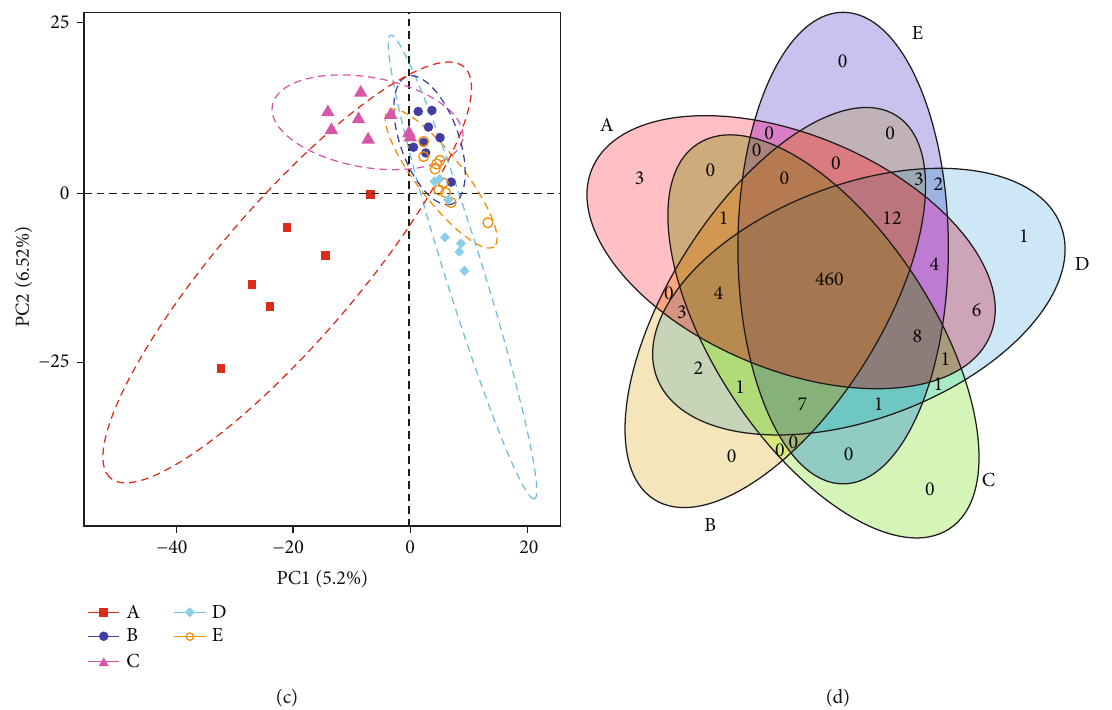
Figure 2: Bacterial diversity of intestinal microbiota in di ff erent groups. (a) Rarefaction curve of all samples (the abscissa is the number of sequencing strips randomly selected, and the ordinate is the number of OUT). (b) Index of alpha diversity shown in Chao1 index to estimate species abundance and diversity of microbial communities. (c) β -Diversity analysis was performed by partial least squares discrimination analysis (PLS-DA). (d) Venn diagram was used to show the number of common and unique OTUs among samples of each group (di ff erent groups were represented by di ff erent colors, and the digital in the overlapping graph was the number of OTUs shared by di ff erent